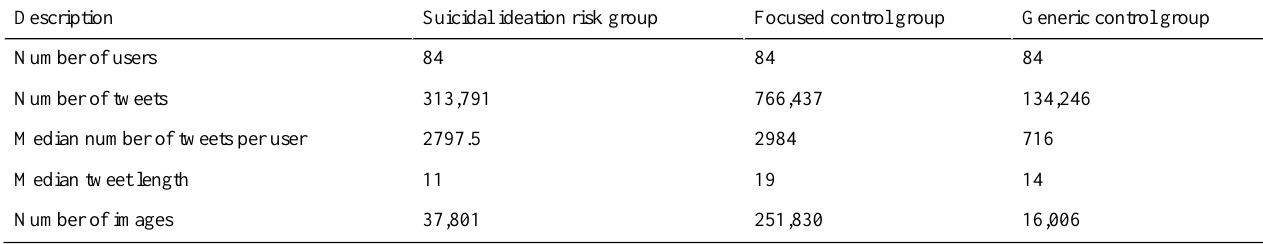
Table 5. Full dataset labeled group